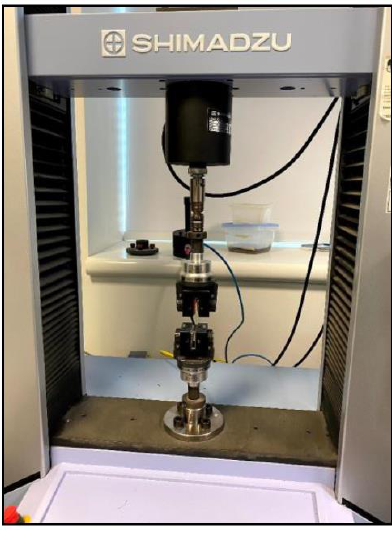
Figure 9. Tensile testing machine.